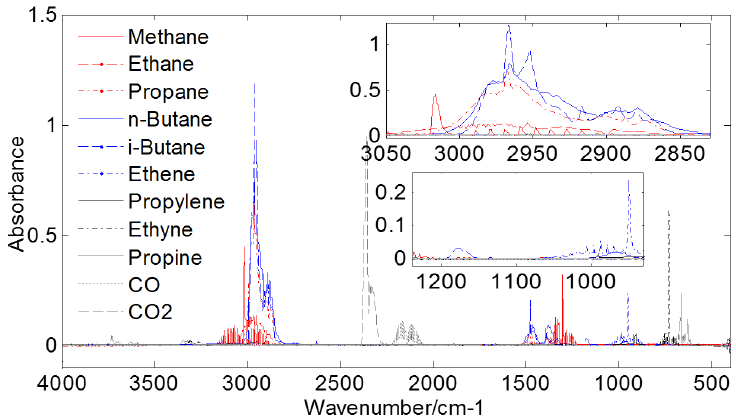
Figure 4. Absorption spectra of analytes and interferents with a concentration of 1000 ppm.